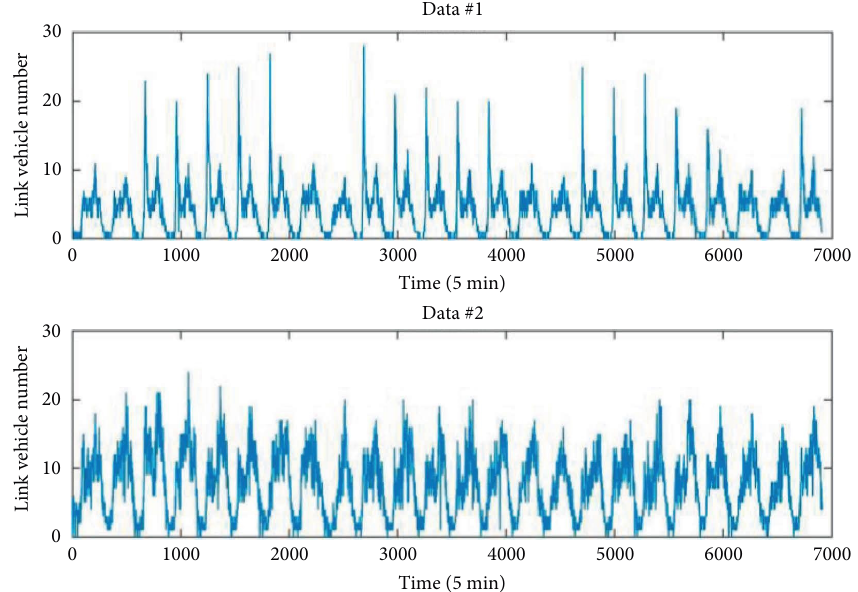
Figure 4: Link dynamic vehicle count